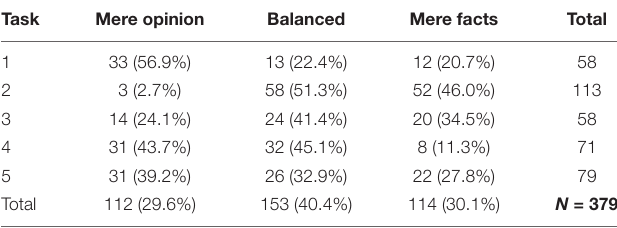
TABLE 6 | Level of facticity of the visited websites per task 1